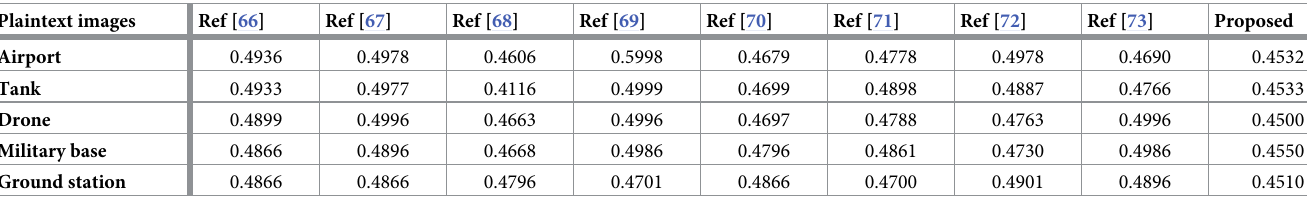
Table 8. Homogeneity